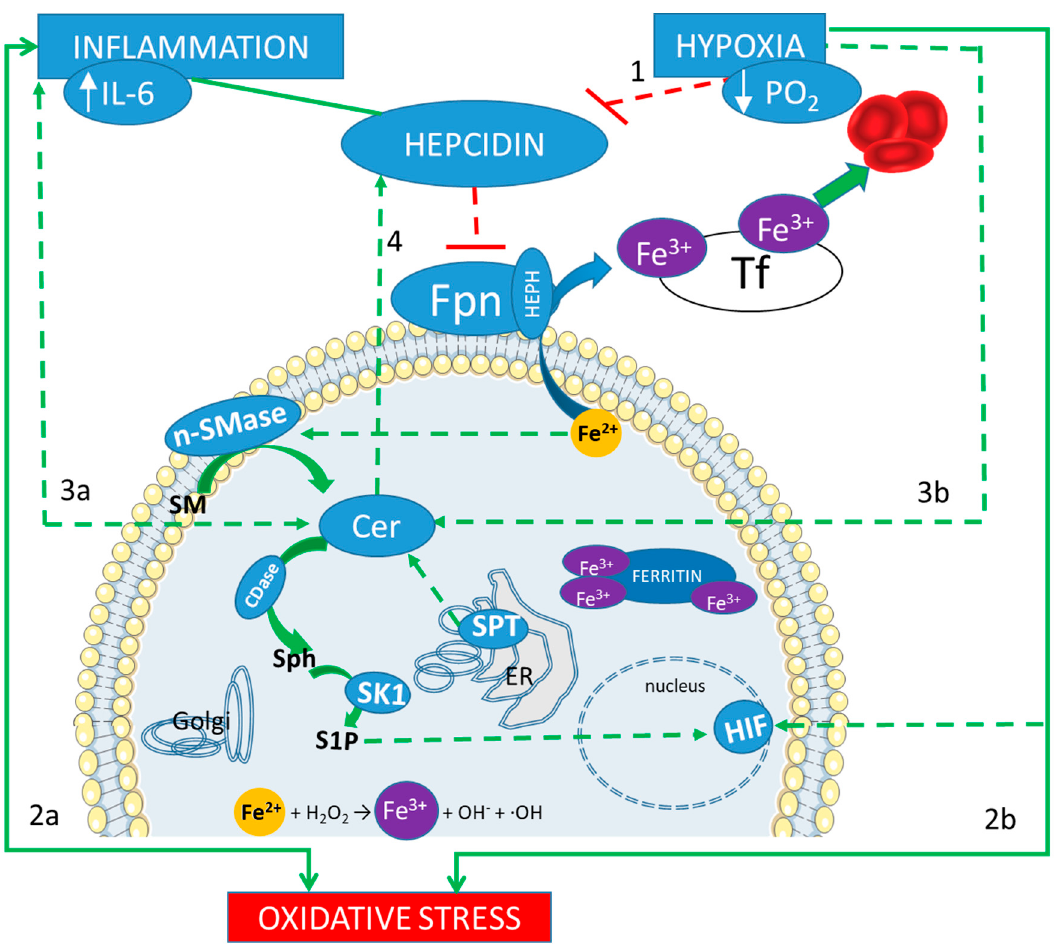
Figure 1. Iron and sphingolipids interplay in response to inflammation and hypoxia. A correct adaptation to hypoxia results in the inhibition of the regulator peptide hepcidin (line 1). Hepcidin main action is the reduction of the outflow of the intracellular ferrous iron (Fe 2 + ), which is mediated by ferroportin (Fpn). Therefore, if Fpn is less inhibited, iron can be released in the blood stream, bound to the trasporter fransferrin (Tf) in its ferric form (Fe 3 + ), and then reach the bone marrow, to contribute to the hematopoietic response. On the other hand, inflammation induces an increase in hepcidin, which blocks such adaptation. Both inflammation and hypoxia are sources of oxidative stress (lines 2a and 2b). An excess of intracellular iron can be a further source of oxidative stress, through the Fenton reaction (showed at the bottom). Both inflammation and hypoxia increase the production of Ceramide (Cer, lines 3a and 3b) derived by a de novo biosynthetic pathway, mediated by serin palmitoyl transferase (SPT) in the endoplasmic reticulum (ER), and by the hydrolysis of sphingomyelin (SM), mediated by neutral sphingomyelinase (nSMase). Cer accumulation promotes hepcidin expression (line 4) with a consequent increase in intracellular iron content, which, in turn, triggers Cer production (via activation of SM hydrolysis) in a vicious loop. Furthermore, ceramidase (CDase) converts Cer in sphingosine (Sph), which is phosphorylated by sphingosine kinase 1 (SK1) to produce sphingosine 1 phosphate (S1P). S1P acts as an oxygen-independent regulator of